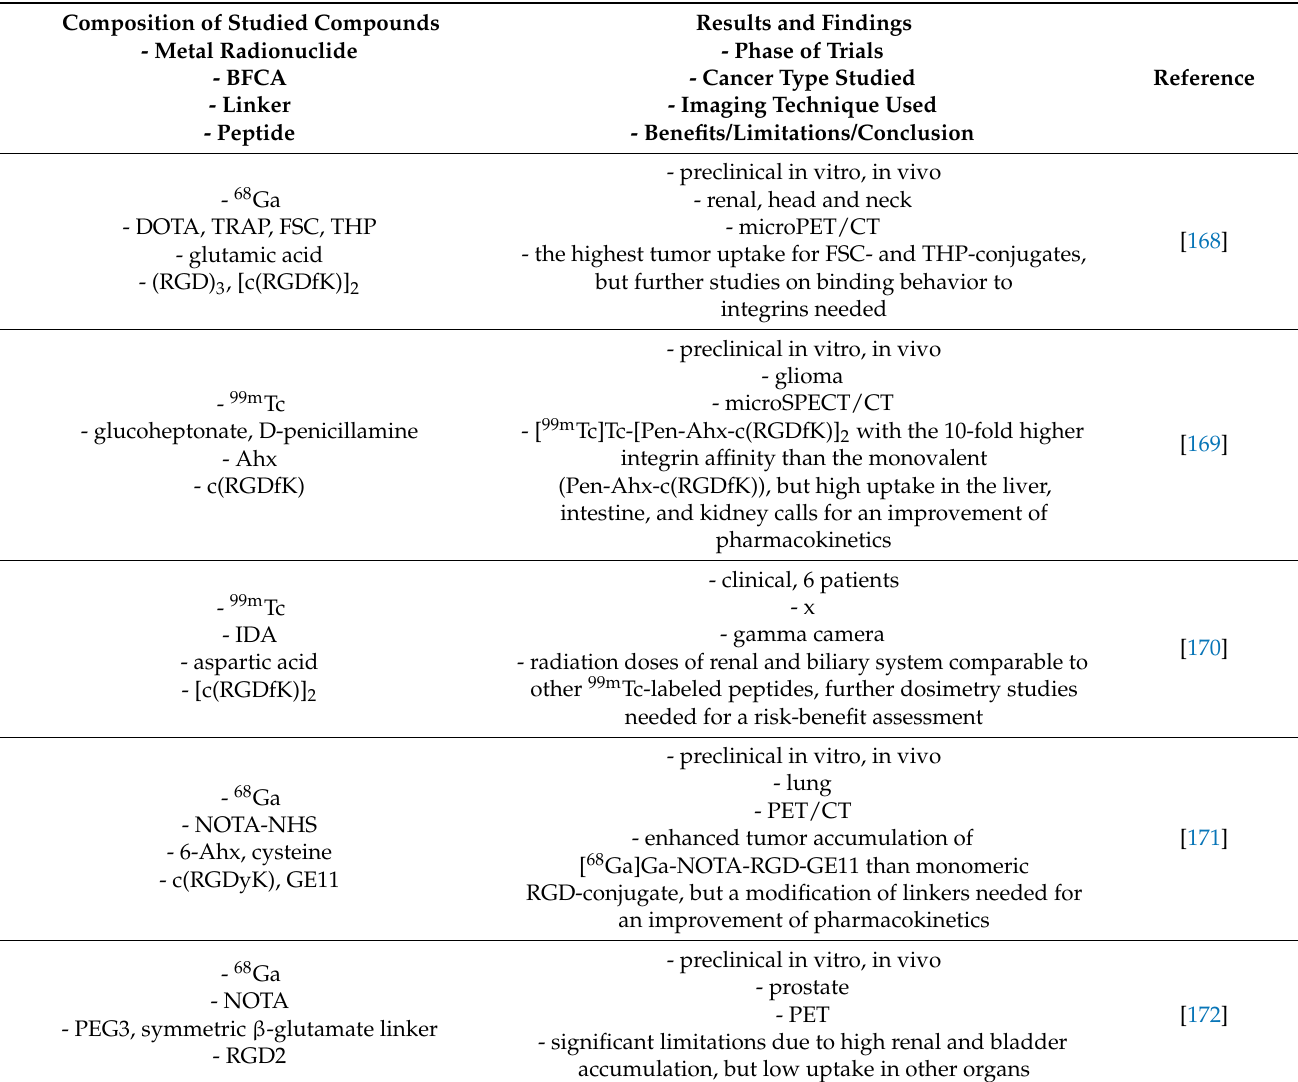
Table 11. Summary of radiolabeled RGD analogues for α v β 3 receptor-positive tumor imaging over past 3 years. Composition of Studied Compounds